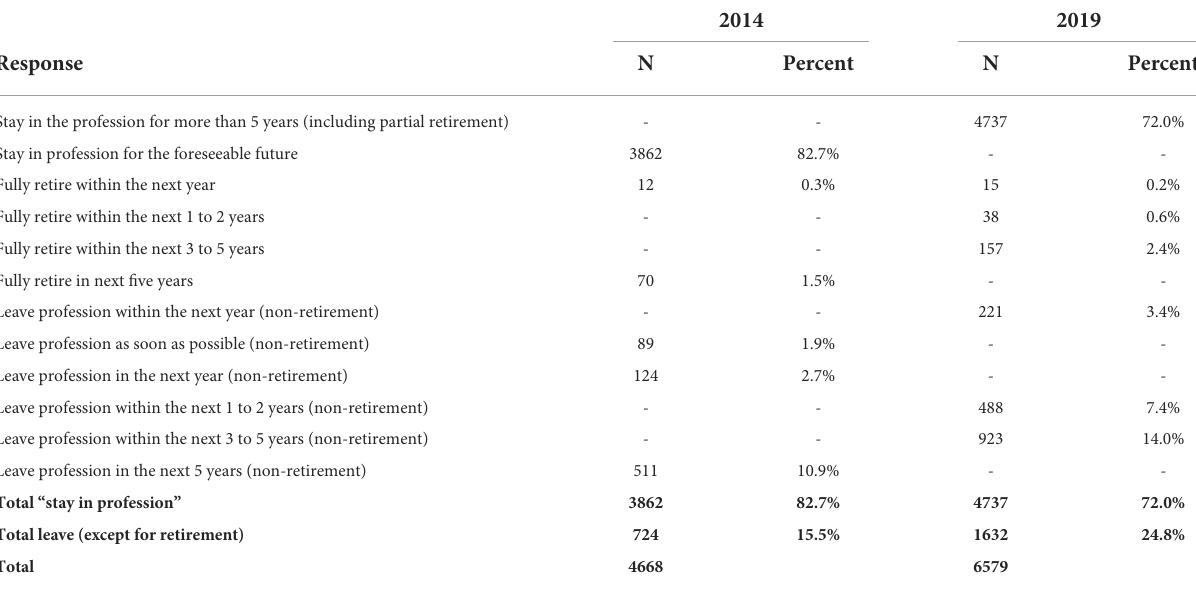
TABLE 2 Intention to stay or leave